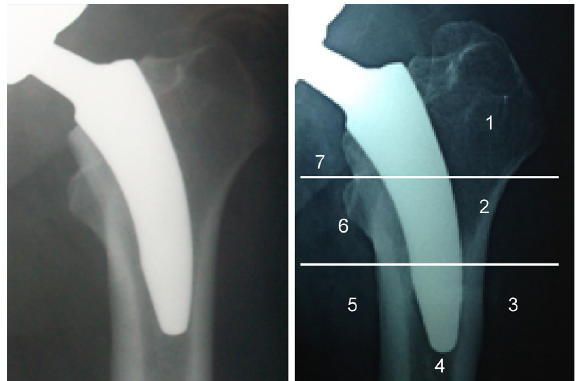
Figure 1. Regions of interest (RIOs) according to Gruen’s zones.